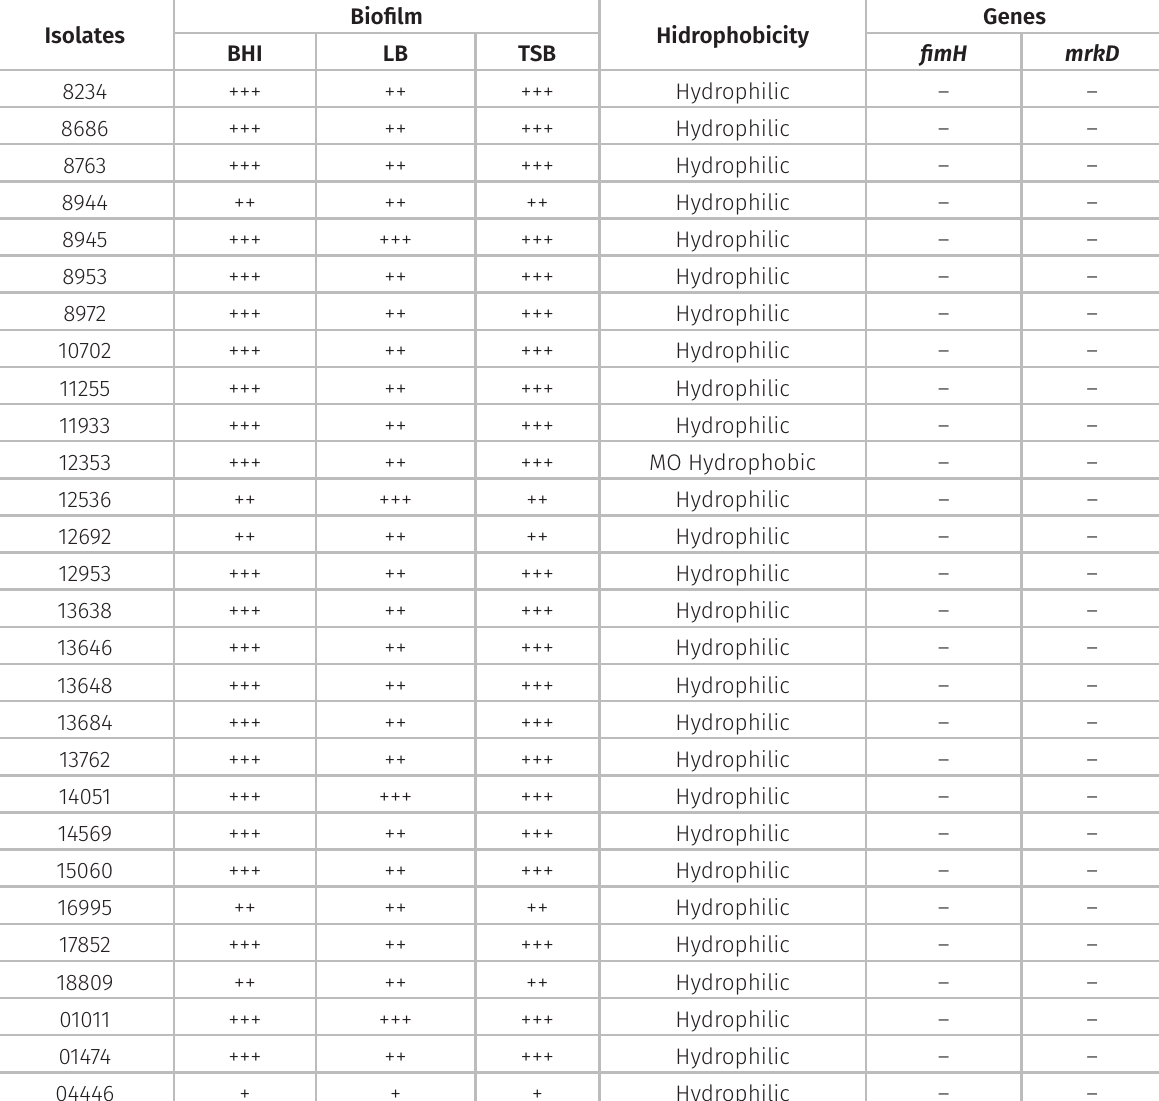
Table I. Biochemical and genetic characteristics of the investigated isolates.